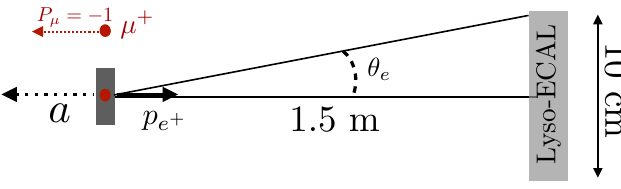
Figure 5 . The proposed MEGII-fwd set-up. A Lyso-ECAL detector of 10 cm in diameter is placed along the muon beam line 1 . 5 m downstream from the stopping point. The muon polarization P is in the opposite direction than the detected